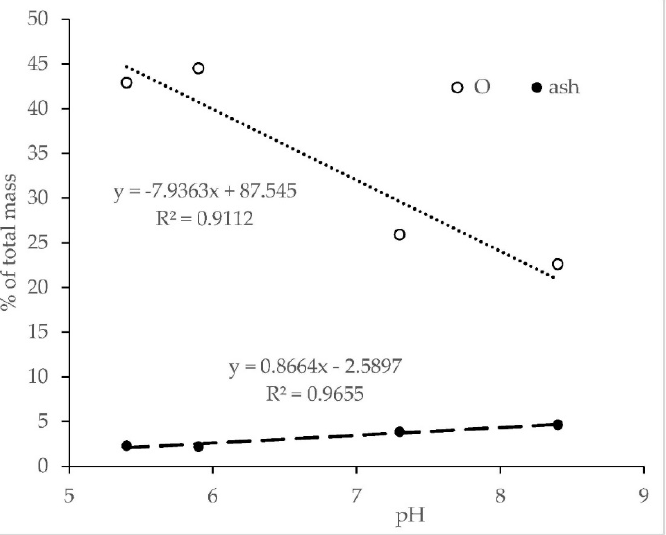
Figure 6. Relationship between oxygen loss and ash content with pH during pyrolysis of Acrocomia endocarp.